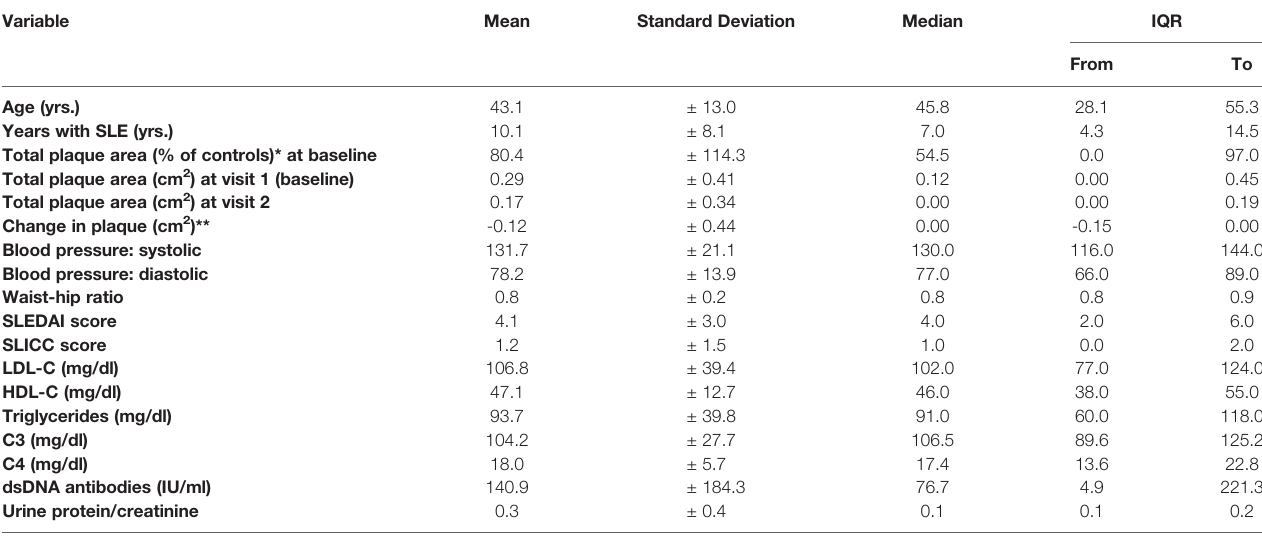
N = 39 (Females: 35 (89.7%), Males: 4 (10.3%), All African Americans. * % of age- and sex-matched historical controls. ** Absolute change in plaque from baseline (visit 1) to visit 2 (approximately 12 months apart). IQR, Interquartile range; SLEDAI, Systemic lupus erythematosus disease activity index; SLICC, Systemic Lupus International Collaborating Clinics; LDL-, HDL-C; HDL-,